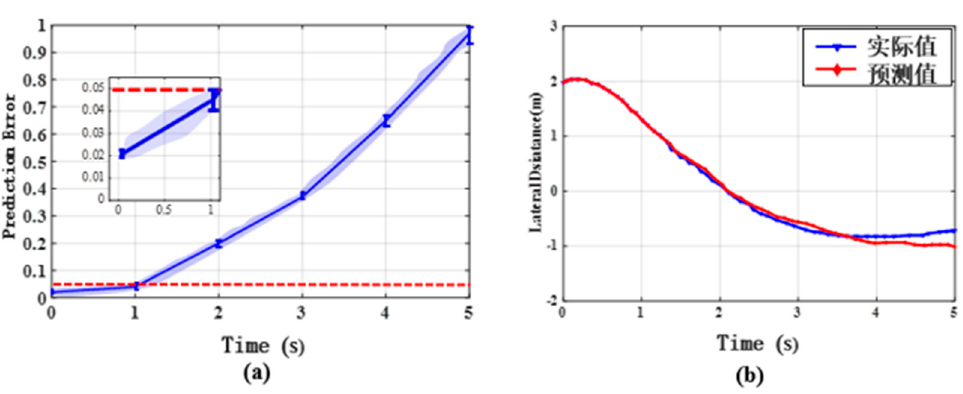
Figure 11. ( a ) Prediction errors of ϵ ‐ greedy LSTM model as the prediction time increases from 0 s to 5 s; ( b ) prediction results of lateral distance in the five seconds.